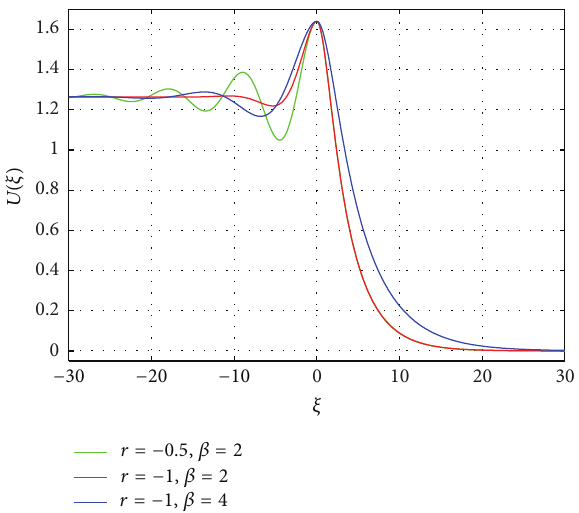
Figure 19: Plot of the approximate damped oscillatory solution (33) for different values of 𝑟 , 𝛽 with 𝑎 = −0.2 , 𝑏 = 0.6 , 𝑐 = 0.2 , and 𝑝 = 2 .